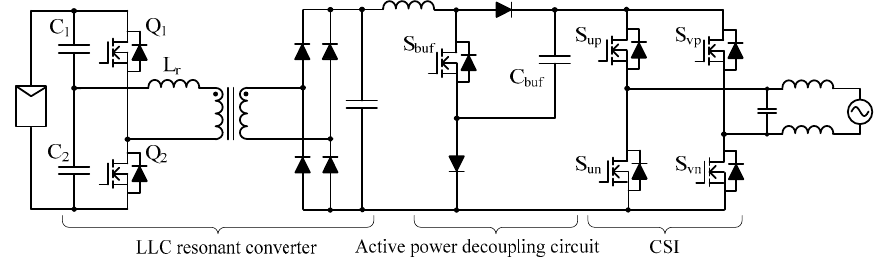
Figure 2. Circuit configuration of DC to Single-phase AC converter using LLC resonant converter.